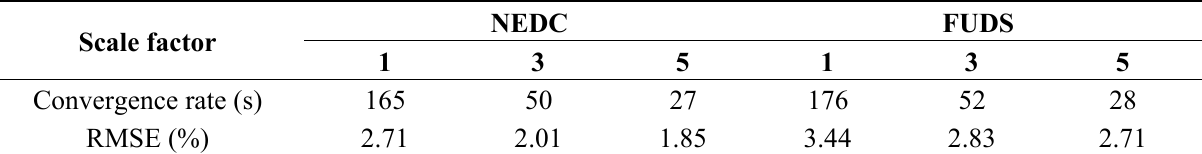
Table 4. Comparison of convergnece rate and SOC estimation error.